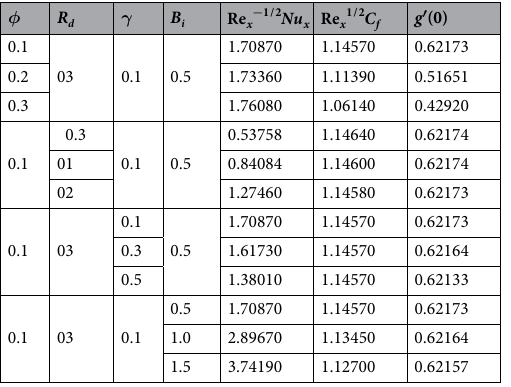
Table 4. Numerical values of Nusselt